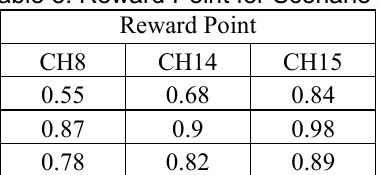
Table 8. Reward Point for Scenario-3